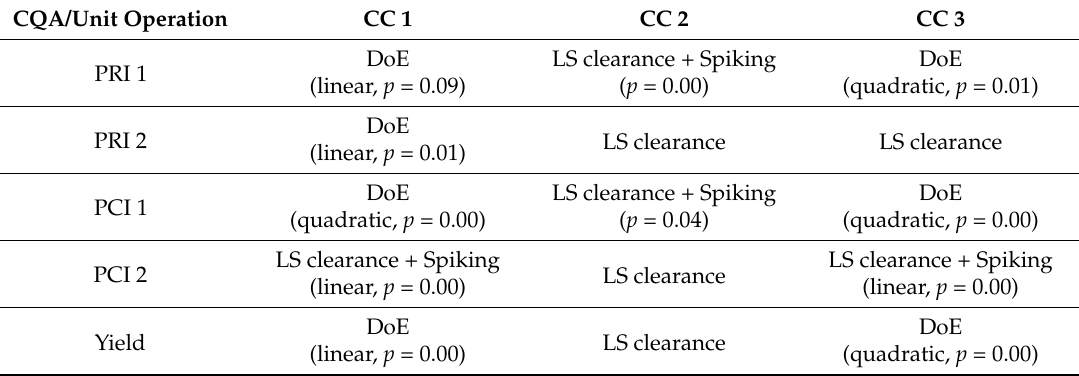
Table 2. Summary of the presence of models that describe the relationship of a CQA specific clearance factor as a function of PPs (indicated by “DoE”) or the impurity loading density of the respective CQA (“Spiking”) and the respective p -value of the regression. In cases where no significant function of PPs on a CQA clearance could be found, mean large scale clearance was assumed indicated by “LS clearance” in the table. CC is abbreviation for chromatography column, PCI stands for process-related impurities and PRI product-related